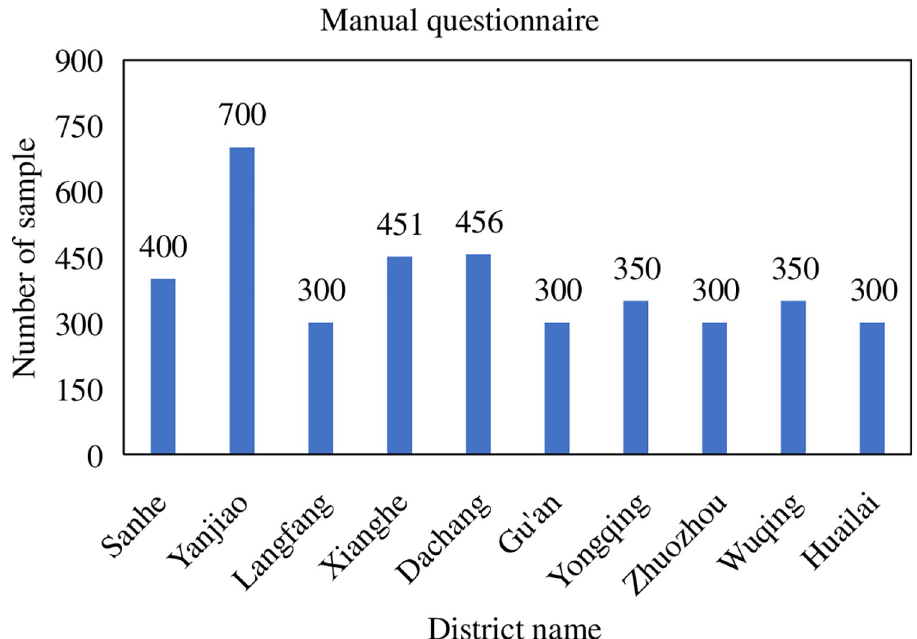
Fig 2. Survey sample size—artificial questionnaire.